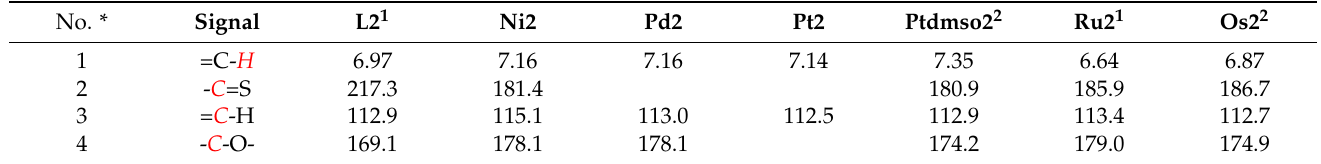
Table 1. Selected 1 H and 13 C NMR signals for compound 2 dissolved in CDCl 3 [ppm]. Ni, Pd, and Pt complexes show similar chemical shifts compared to the PtDMSO complex for signals 1–4 [18]. Chemical shifts differ from those observed for Ru and Os compounds [50].